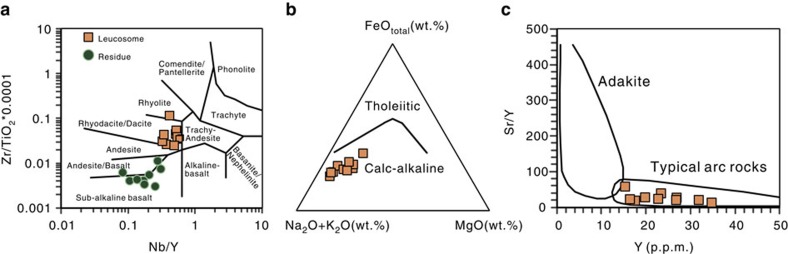
Geochemical plots of ten rock pairs of leucosome and residue.These samples were collected in the region between two quartz porphyry dikes of Fig.1c. (a) Geochemical plot of Yangkou Bay leucosome and residue samples in the Nb/Y versus Zr/TiO2 ratio diagram from58. (b) Distribution of Yangkou Bay leucosome samples in the FeOtotal-Na2O+K2O-MgO ternary diagram from ref. 59, wt.%, weight percent. (c) Diagram for Sr/Y ratios versus Y contents (p.p.m.) for the Yangkou Bay leucosomes. The fields for adakites and typical arc rocks are after Defant and Drummond51. See original data from Supplementary Data Set 1 and 2.